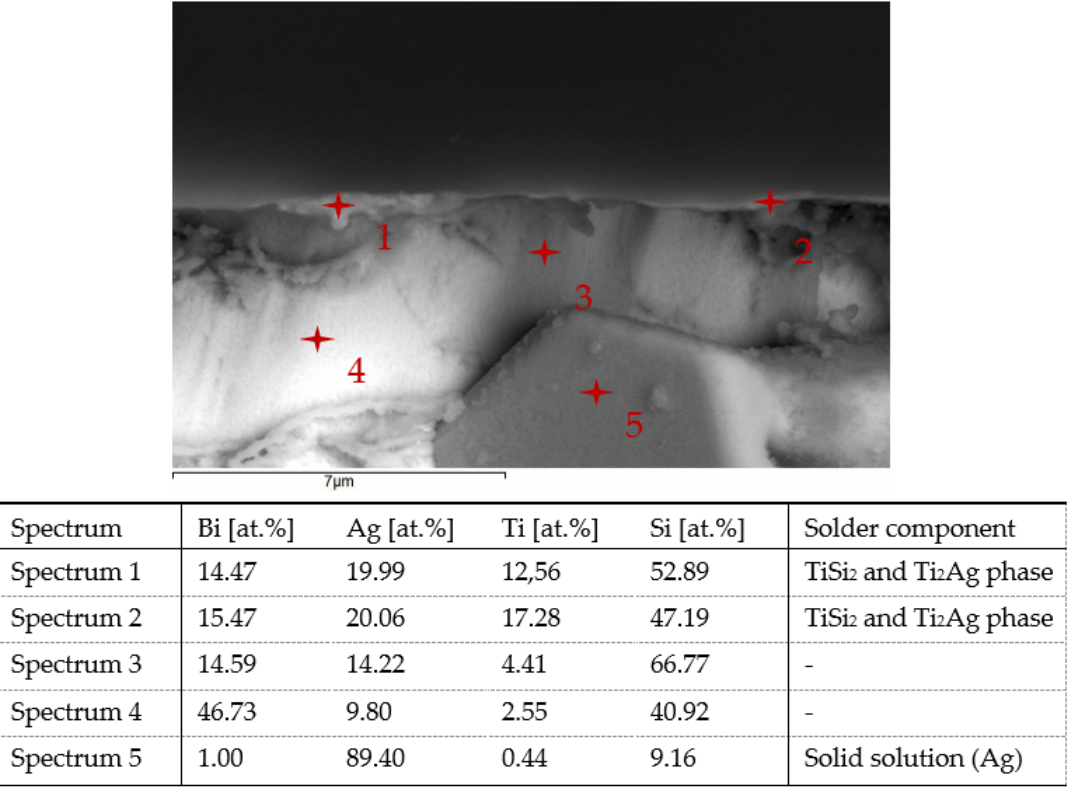
Figure 12. Point EDX analysis of Si/Bi11Ag1.5Ti joint.